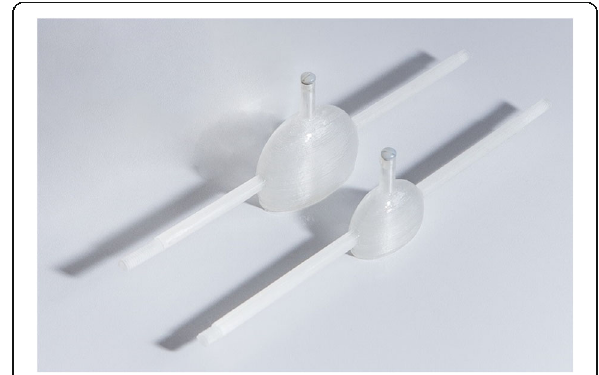
Fig. 1 3D-printed 1-year-old and newborn kidney phantoms [12] `